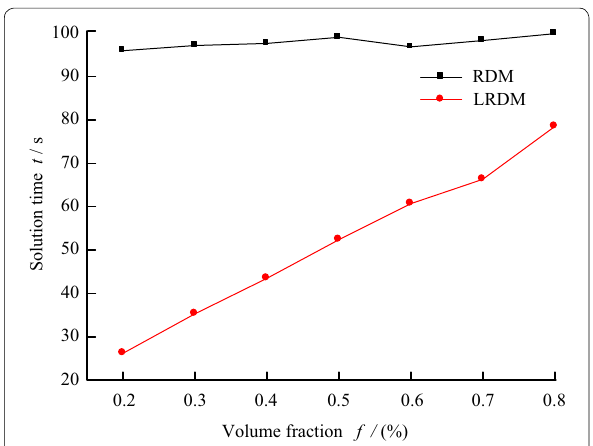
Figure 9 Comparison of the solution time of generated lattice structure for various volume fractions